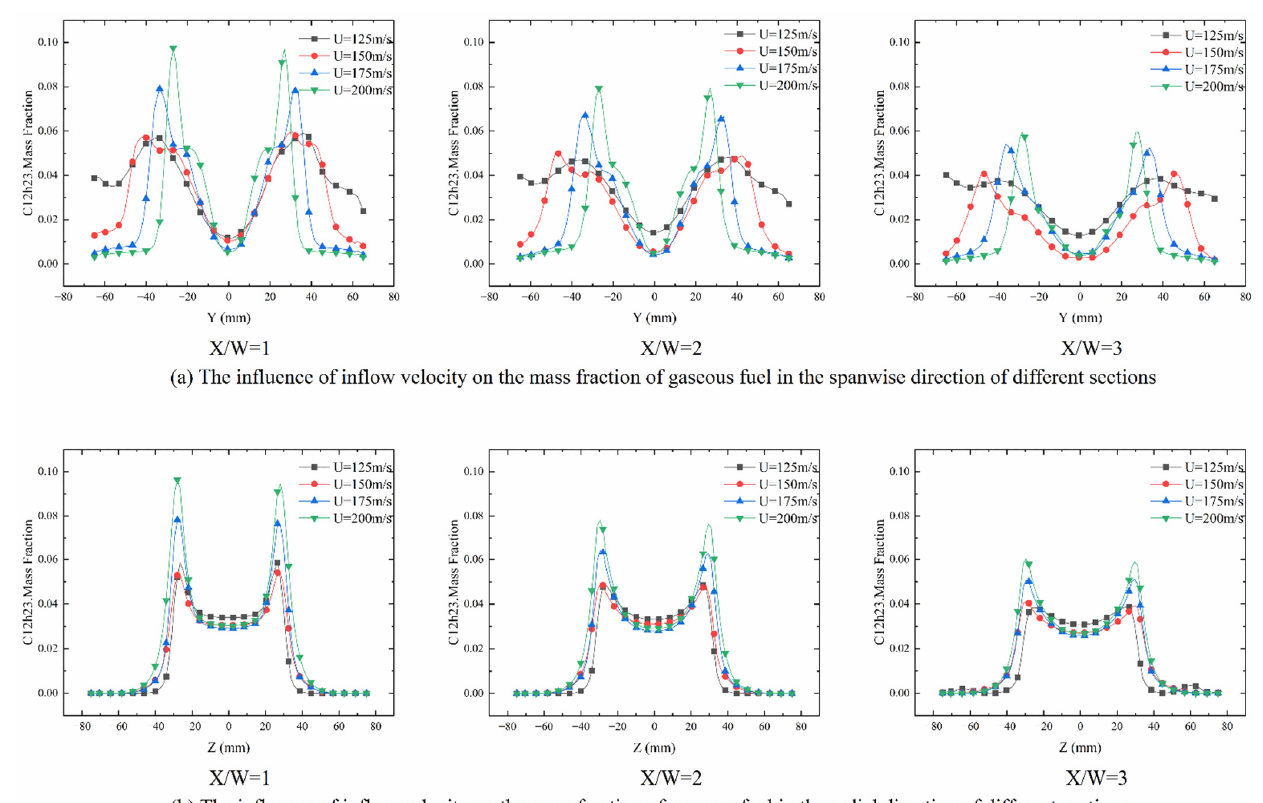
Figure 11. The influence of inflow velocity on the mass fraction of gaseous fuel of different sections. Figure 12a,b present the influence of the incoming flow temperature on the mass fraction of the gaseous fuel in the spanwise and radial directions of different